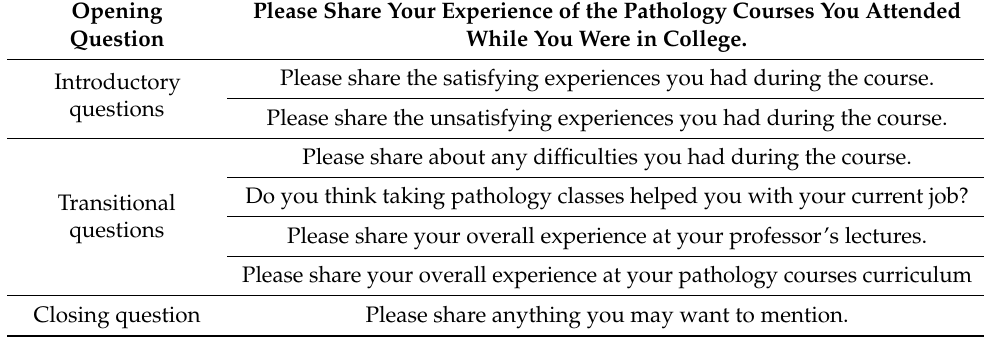
Table 2. Questions for this